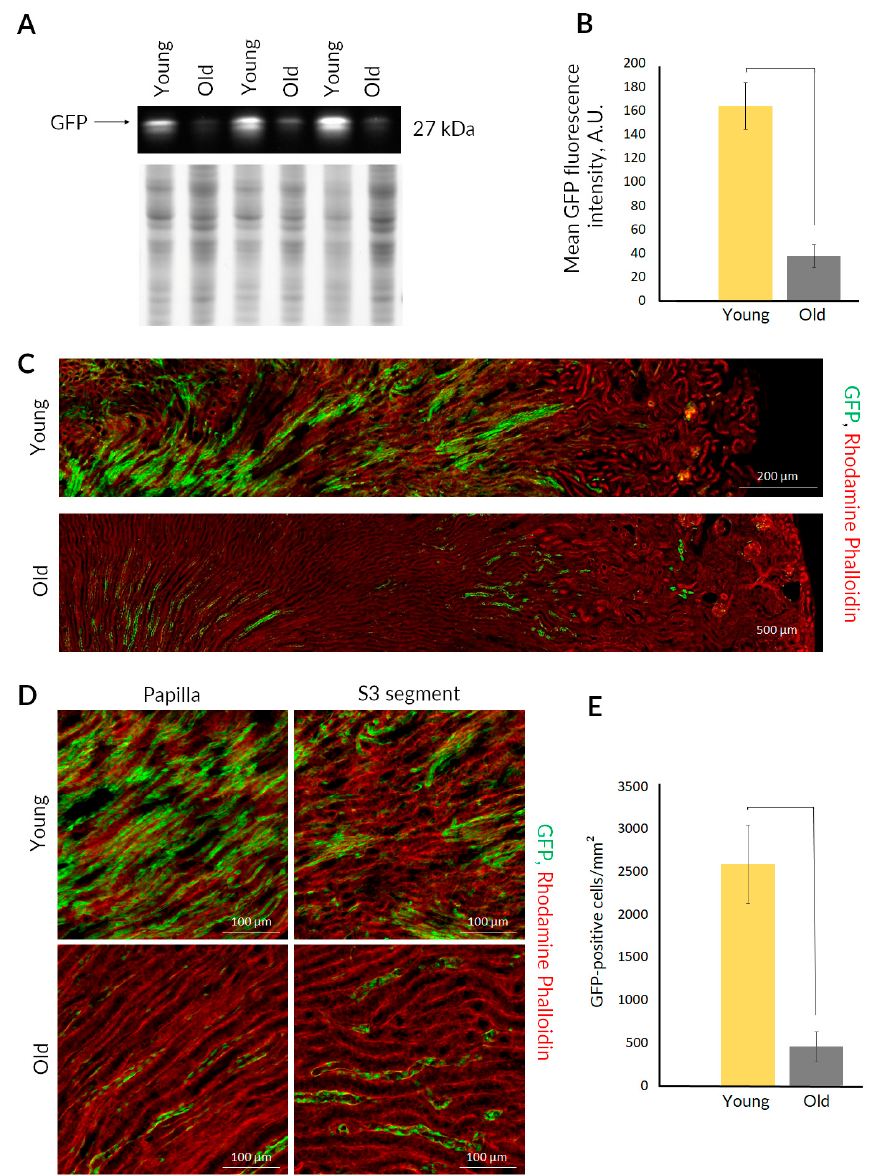
Figure 2. The presence and number of nestin + cells in kidneys of young and old nestin-GFP mice. ( A ) GFP bands after PAGE of kidney homogenates and their normalization on total protein loading (performed by Stain-free imaging) ( n = 3). ( B ) Normalized fluorescence intensity of GFP bands after PAGE of kidney homogenates (mean ± SD; p -value < 0.05 (U-test)). ( C ) Representative confocal images of kidney slices stained with rhodamine-phalloidin ( n = 3). ( D ) Representative confocal images of S3 segment and papilla in kidney slices stained with rhodamine-phalloidin ( n = 3). ( E ) The number of GFP-positive cells on kidney slices (mean ± SD; p -value < 0.05 (U-test)).